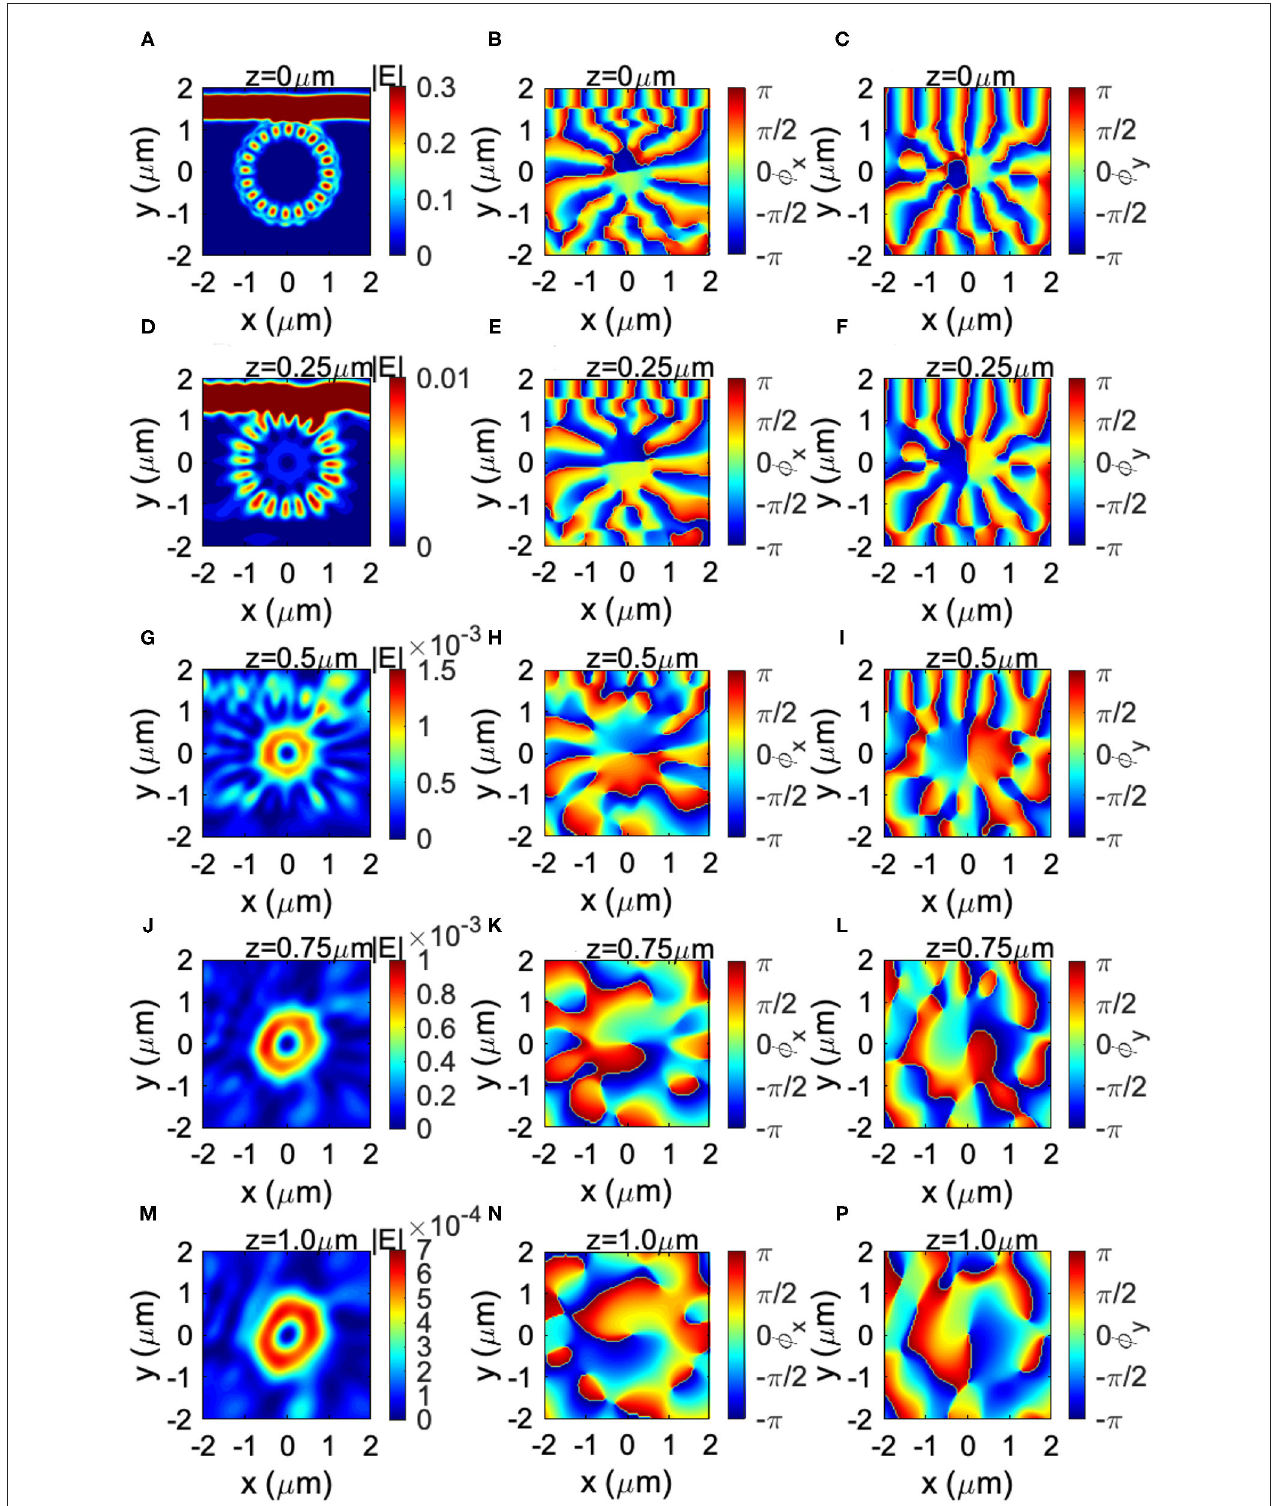
FIGURE 6 | Generation of left vortex from the gear of N z 0,0.25,0.5,0.75, and 1 µ m above the gear, which are shown in (A–C) , (D–F) , (G–I) , (J–L) , and (M–P) , respectively. The amplitude = phases φ x arg( E x ) and φ y arg( E y ) are shown in (A,D,G,J,M) , (B,E,H,K,N) , and (C,F,I,L,P) , respectively. = =